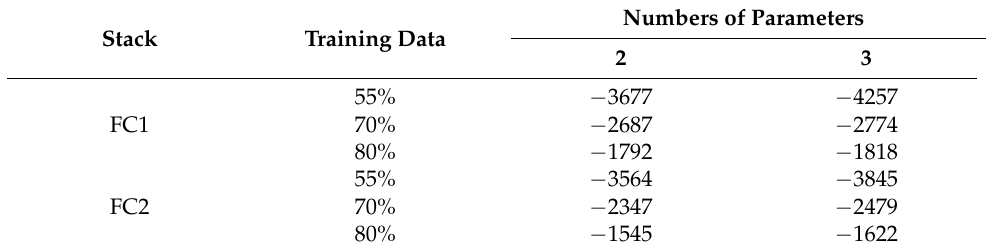
Table 2. AIC of the degradation models with different parameters for FC1 and FC2.